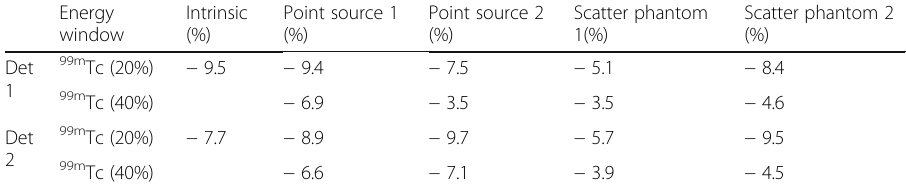
Table 5 Percentage loss of energy window fraction per 100kcps increase in count rate Energy Intrinsic window (%)